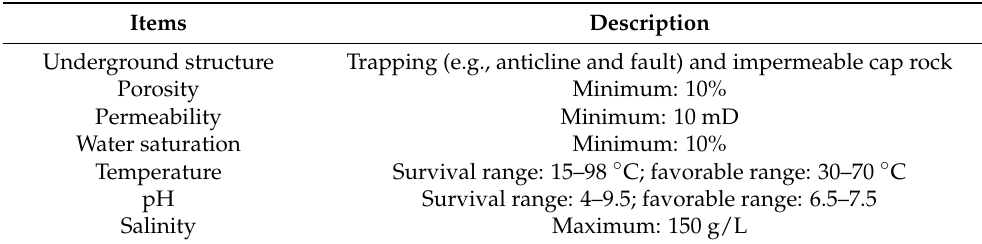
Table 1. Environmental requirements for underground